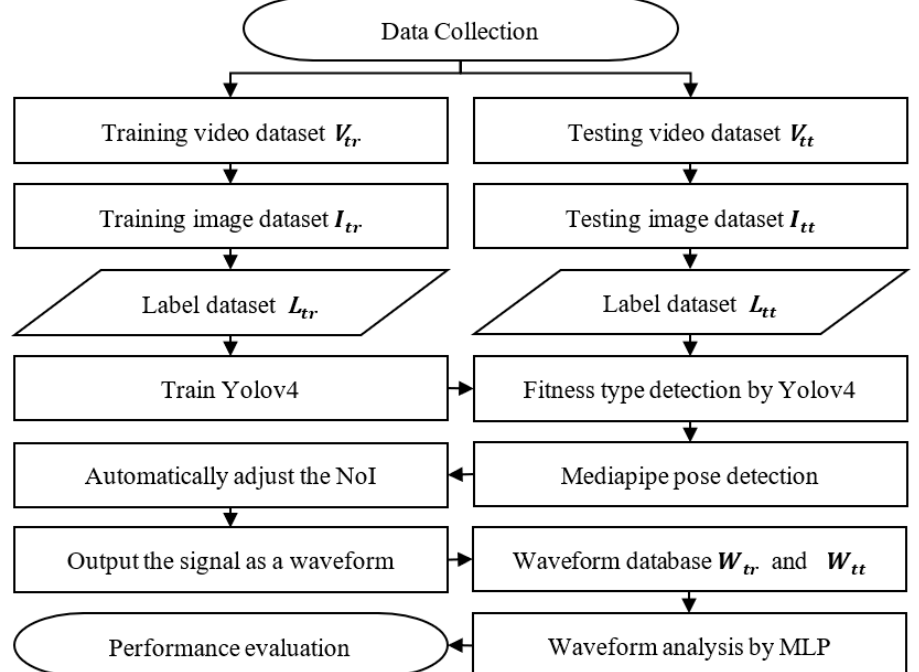
Figure 1. Method flowchart.